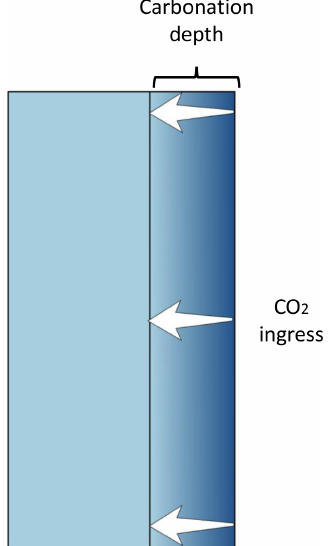
Figure 1. A two-dimensional schematic representation (rectangular cross-section) of the three-dimensional “slab” carbonation model of concretes. The right-hand side that is close to the CO 2 source is being carbonated first, with further carbonation taking place by CO 2 diffusion in the